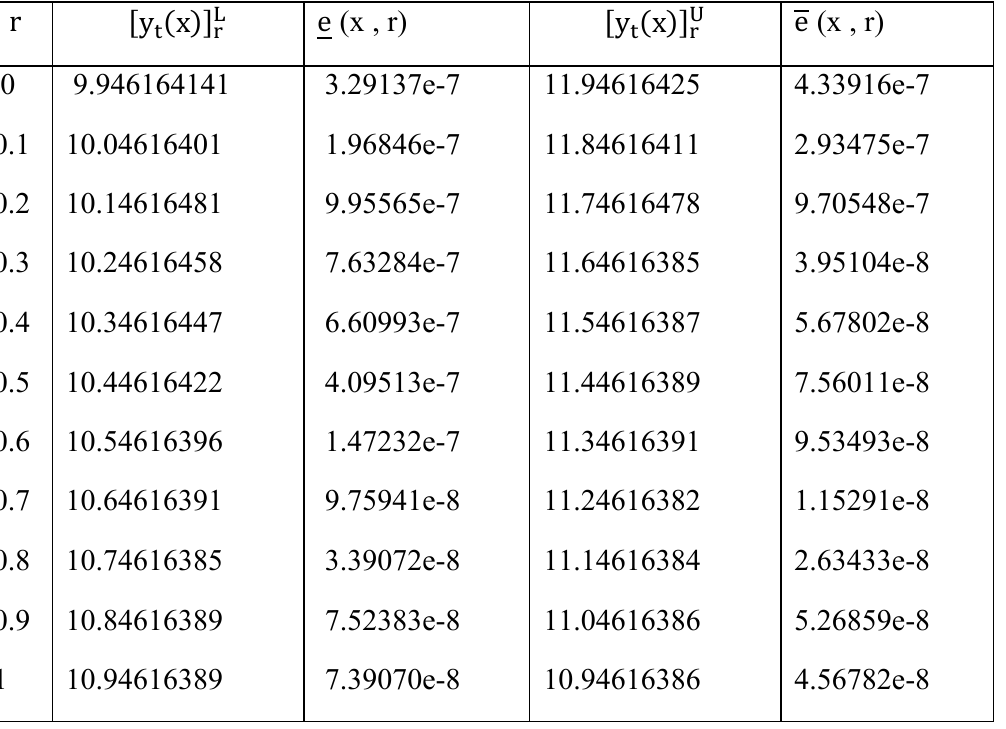
Table (1): Numerical result for example (1),